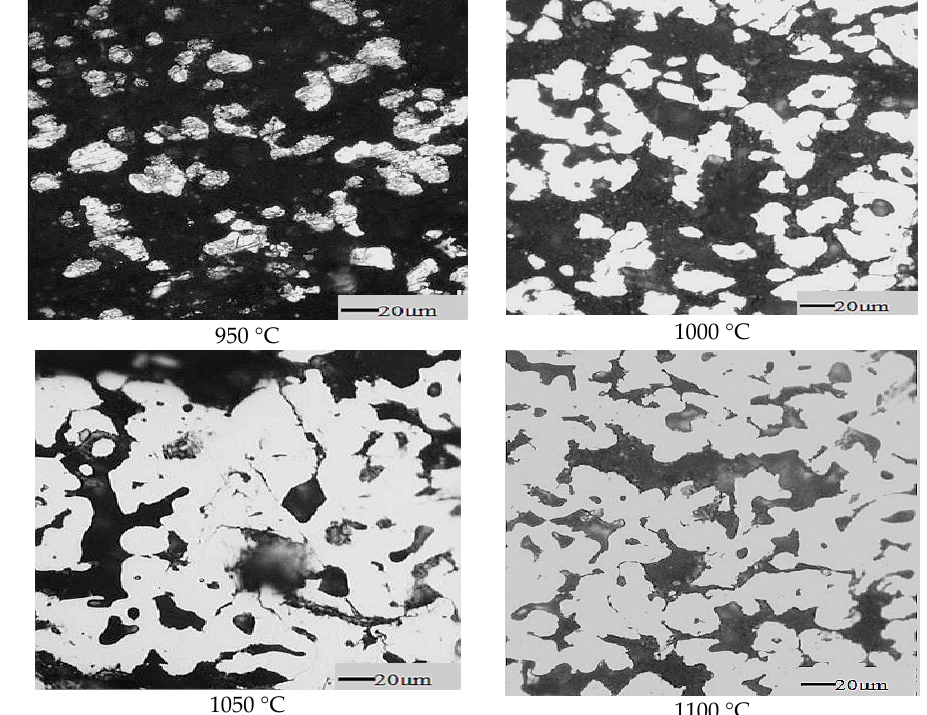
Figure 5. Microstructure of reduced briquettes at different reduction temperature (bright white, metallic iron).